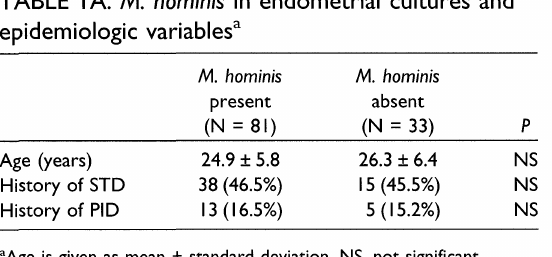
TABLE lB. U. urealyticum in endometrial cultures